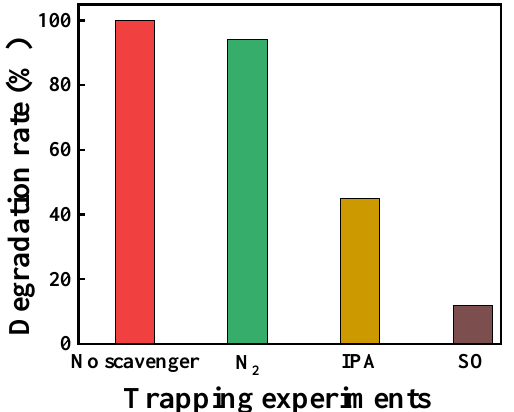
Figure 7. Trapping experiments of BOWC2.